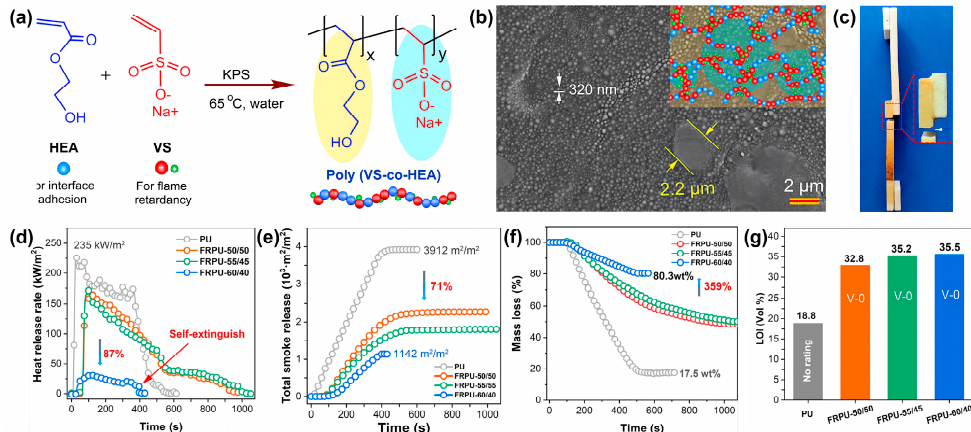
Figure 14. ( a ) Schematic diagram of the synthetic route of poly (VS-co-HEA); ( b ) the phase-separated micro/nanostructure of poly (VS-co-HEA); ( c ) digital photo of poly (VS-co-HEA) coatings versus PU foam following shear testing, during which bulk PU foam broke before interfaces; ( d ) HRR, ( e ) TSR, and ( f ) mass loss curves in UL-94 test; ( g ) LOI of RPUF [69].